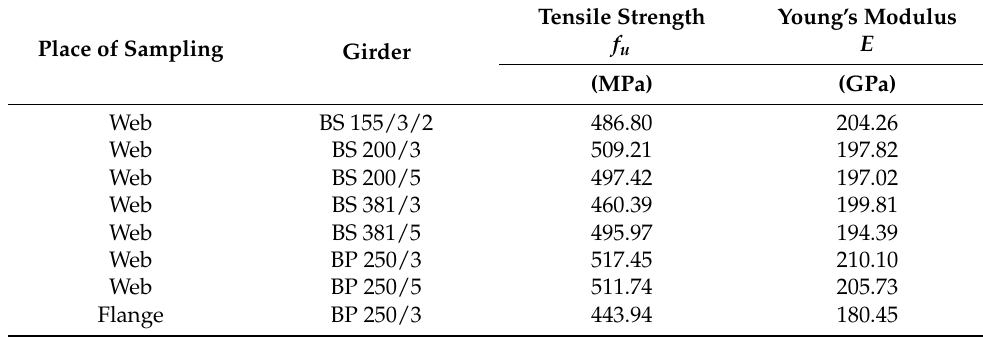
Table 2. Material characteristics of girder steels.